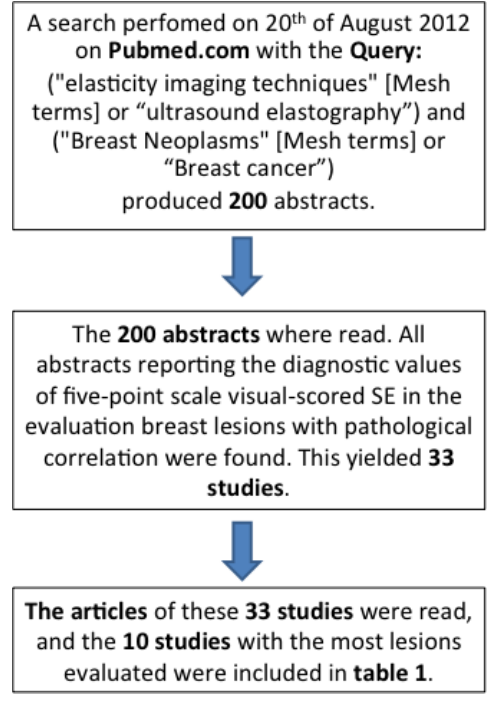
Figure 2. Schematic presentation of the search algorithm for the included